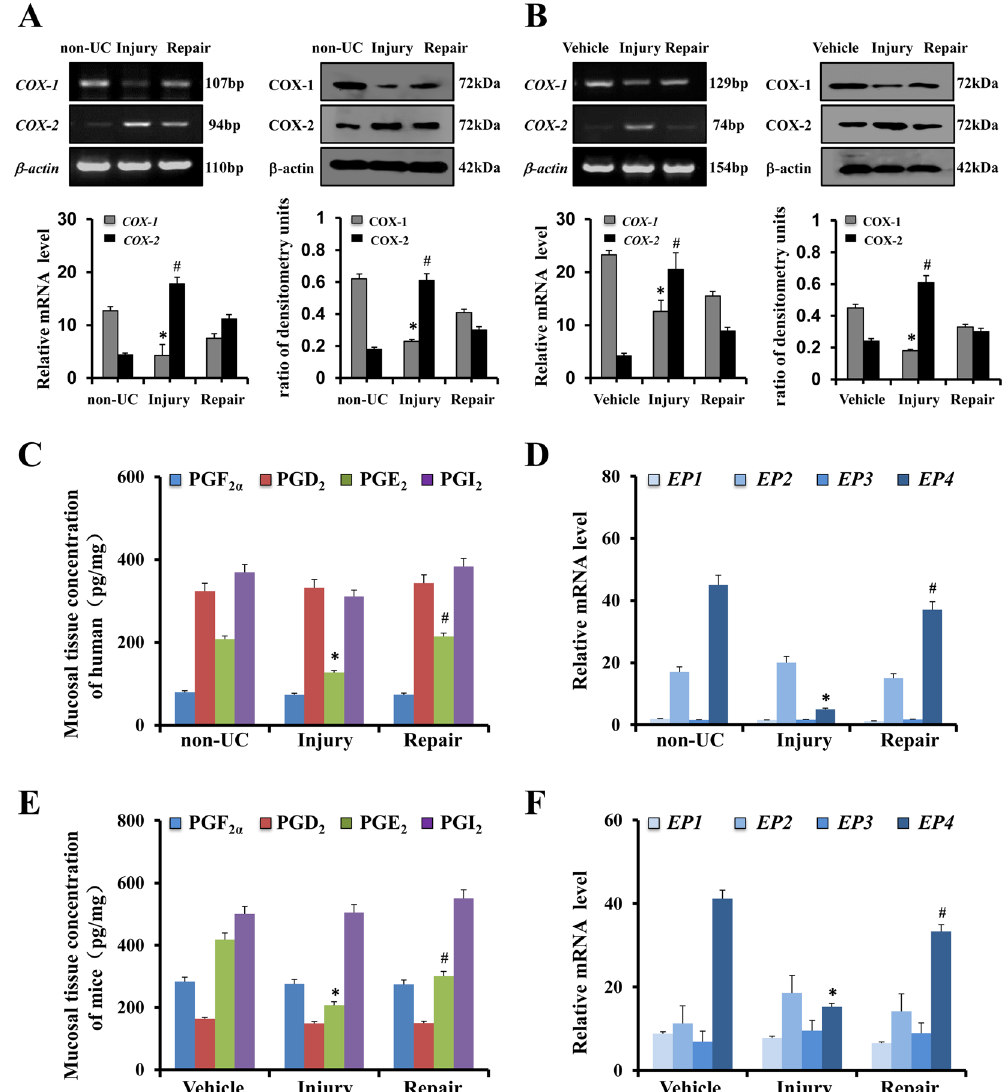
Figure 1. Expression of COX, prostaglandins and prostaglandin receptors in colitis. ( A ) COX-1 and COX-2 expression in colon tissues were determined using RT-PCR and Western blotting in the non-UC group (human normal colon tissue), injury group (colitis colon tissue in the injury phase) and repair group (colitis colon tissue in the repair phase); β -actin was used as a loading control (n = 6 per group). * P < 0.05, # P < 0.05 non-UC versus injury. ( B ) COX-1 and COX-2 expression in mouse colon tissue was determined using RT-PCR and Western blotting analyses in the vehicle group, injury group and repair group. (n = 4 per group) * P < 0.05, # P < 0.05 vehicle versus injury ( C ) Concentrations of mucosal prostaglandins PGE 2 , PGD 2 , PGF 2 α and PGI 2 in of three pairs of representative human specimens. Values are expressed as the mean ± SD (n = 6 per group). * P < 0.05, non-UC versus injury phase. # P < 0.05 injury phase versus repair phase ( D ) mRNA expression of EP1 , EP2 , EP3 and EP4 in the colonic mucosa were evaluated using real-time PCR in the indicated group. Values are expressed as the mean ± SD (n = 6 per group). * P < 0.05, non-UC versus injury phase. # P < 0.05 injury phase versus repair phase ( E ) Concentrations of mucosal prostaglandins PGE 2 , PGD 2 , PGF 2 α and PGI 2 in the mouse vehicle group, injury group and repair group; The values are expressed as the mean ± SD (n = 4 in each group). * P < 0.05 versus vehicle mice, # P < 0.05 injury group versus repair group. ( F ) EP1 , EP2 , EP3 and EP4 mRNA expression in the colonic mucosa of mice were evaluated by real-time PCR in the indicated group. The values are expressed as the mean ± SD (n = 4 in each group). * P < 0.05 versus vehicle mice, # P < 0.05 injury group versus repair Targeted deletion of β -arr1 exacerbates DSS-induced colitis in mice. The above observations prompted us to use β -arr1 -gene-deficient models to further investigate the role of β -arr1 in colitis. To assess the extent and severity of colonic pathological changes, we measured the length of colons from mice subjected and not subjected to colitis. Although DSS-induced colitis resulted in colon shortening in both β -arr1 WT and KO mice, the colon was still significantly longer in β -arr1 WT mice than in the KO mice (Supplementary Fig. S2). Disease activity index scores were significantly lower in β -arr1 WT mice compared with KO mice (Fig. 4D).